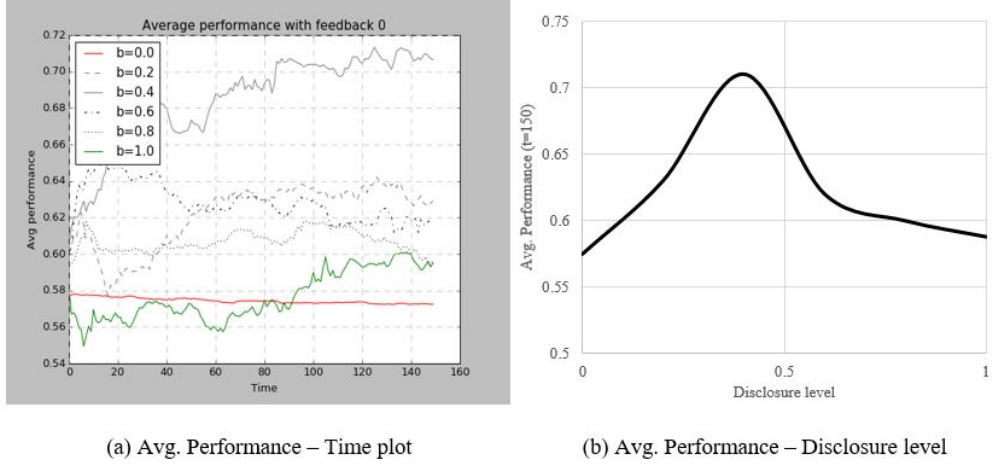
Figure A5. Average performance result of ‘positive feedback to high-performed group and negative feedback to low-performed group’ condition model .